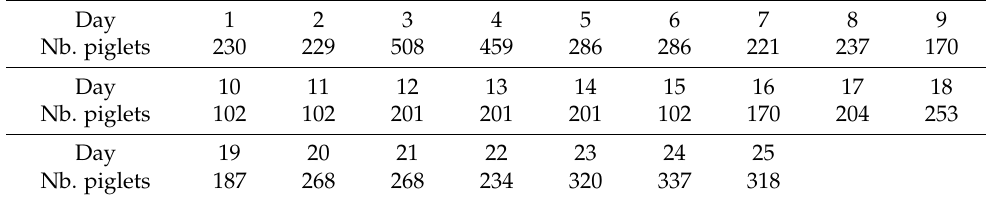
Table 4. Number of piglets with complete data recording during the 5 days following the day given in the first row of the table. As an example, the complete water consumption and body weights were available for 230 piglets on day 1, 2, 3, 4, 5 after the beginning of the post-weaning